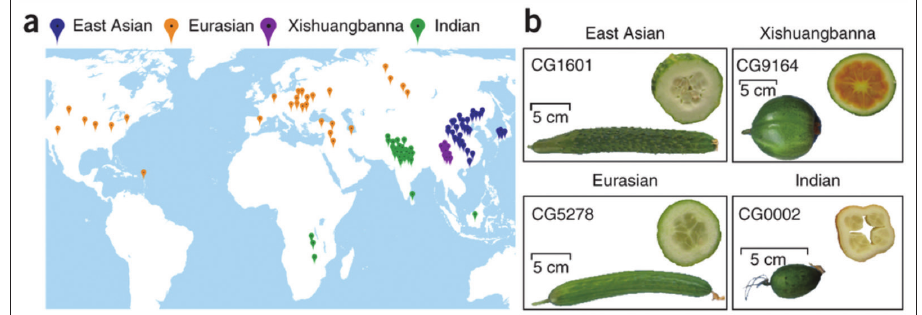
Figure 1. Cucumber populations. a The core collection of 115 lines re-sequenced by Qi et al. (2013). Colour codes indicate geographic groups b Fruit morphology of the four groups. The cucumber line CG1601 (East Asian) bears fruits with dense, white spines and an elongated stalk. Fruits of cucumber line CG5278 (Eurasian) lack spines and have a short fruit stalk. Cucumber line CG9164 (Xishuangbanna) bears melon-like fruits with a low fruit shape index (length/width) and a unique orange endocarp. Cu- cumber line CG0002 (Indian) bears small, oval fruits with sparse, black spines. Note that the images differ in scale. Reproduced from Qi et al. including Renner